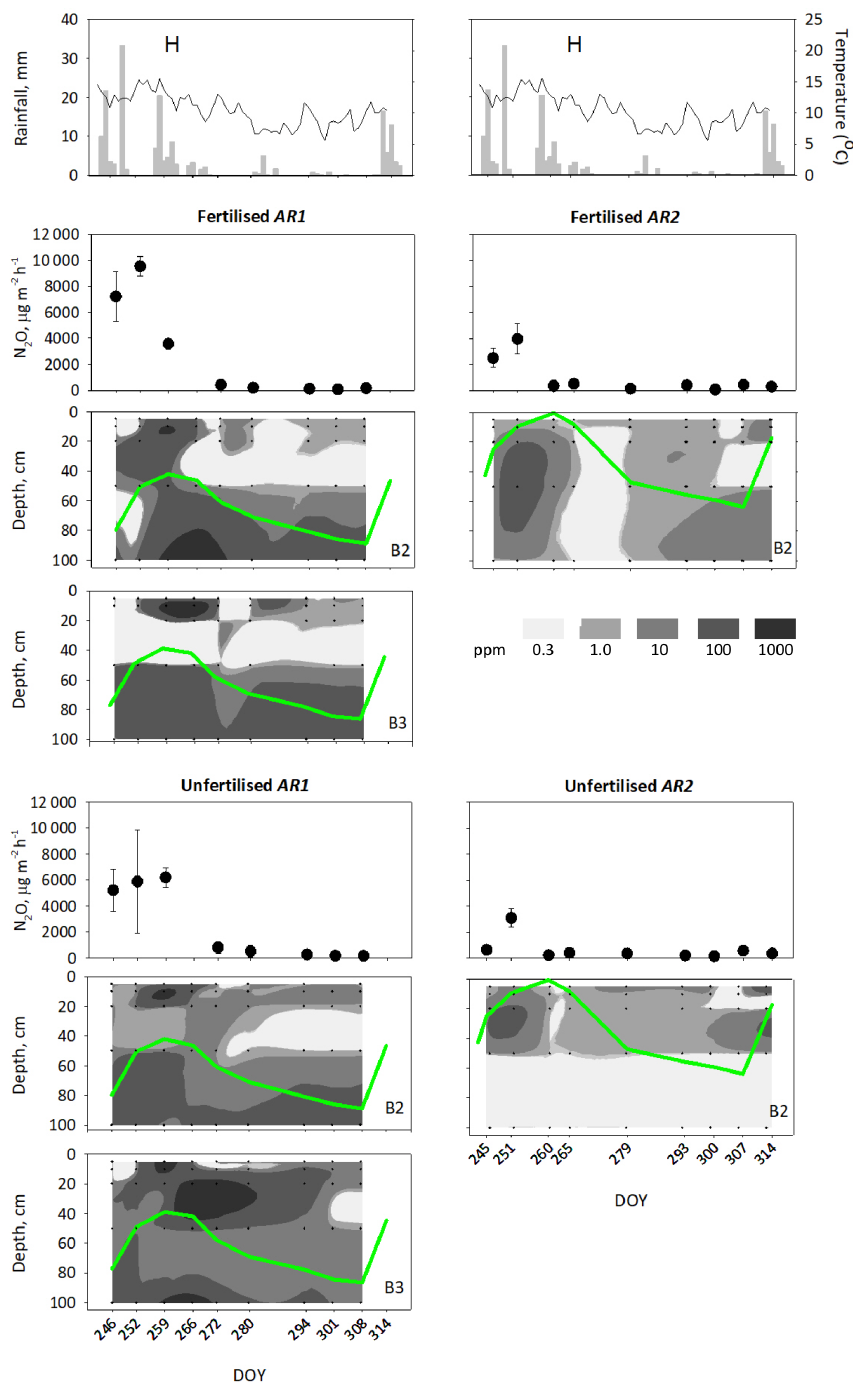
Figure 6. The top panel shows rainfall, air temperature and management ( H – harvest) at AR1 (left panels) and AR2 (right panels) during autumn, 3 September (DOY 245) to 10 November (DOY 314). The middle section shows N 2 O fluxes (black circles; mean ± standard error, n = 3) and contour plots of soil N 2 O concentrations in fertilised subplots, and the lower section shows the corresponding results for unfertilised subplots. A logarithmic grey scale was used in order to show trends within both RG and AR treatments and between depths. Soil gas sampling positions are indicated in the contour plots; numbers shown are N 2 O concentrations (µLL − 1 ). Green lines show the WT depth (which varied slightly between blocks). B2 and B3 refer to block number of diffusion probe